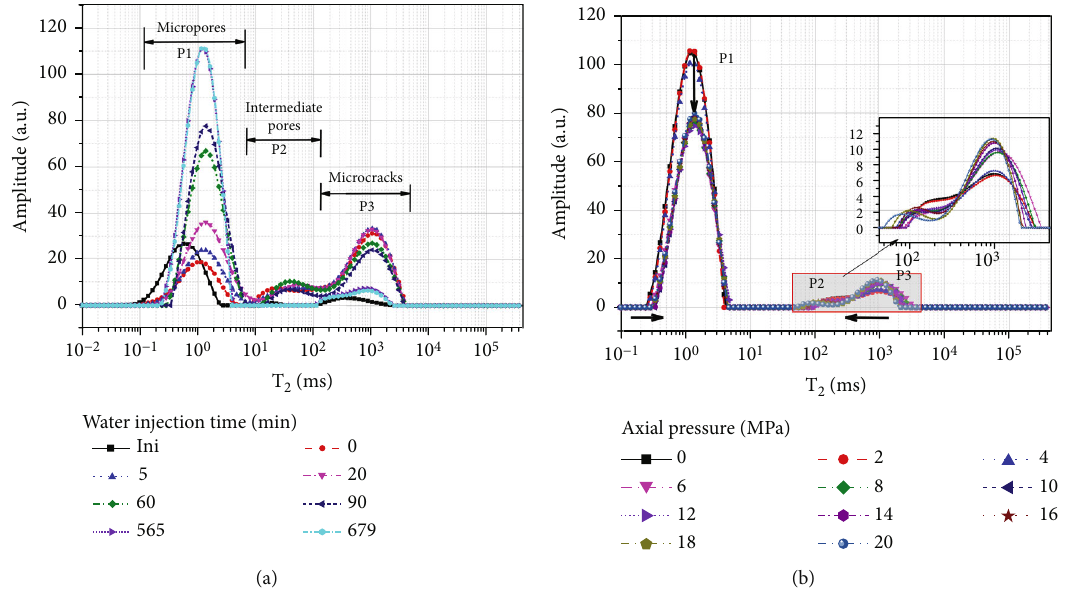
Figure 6: T 2 curves of the sample. (a) Water injection process. (b) Triaxial compression